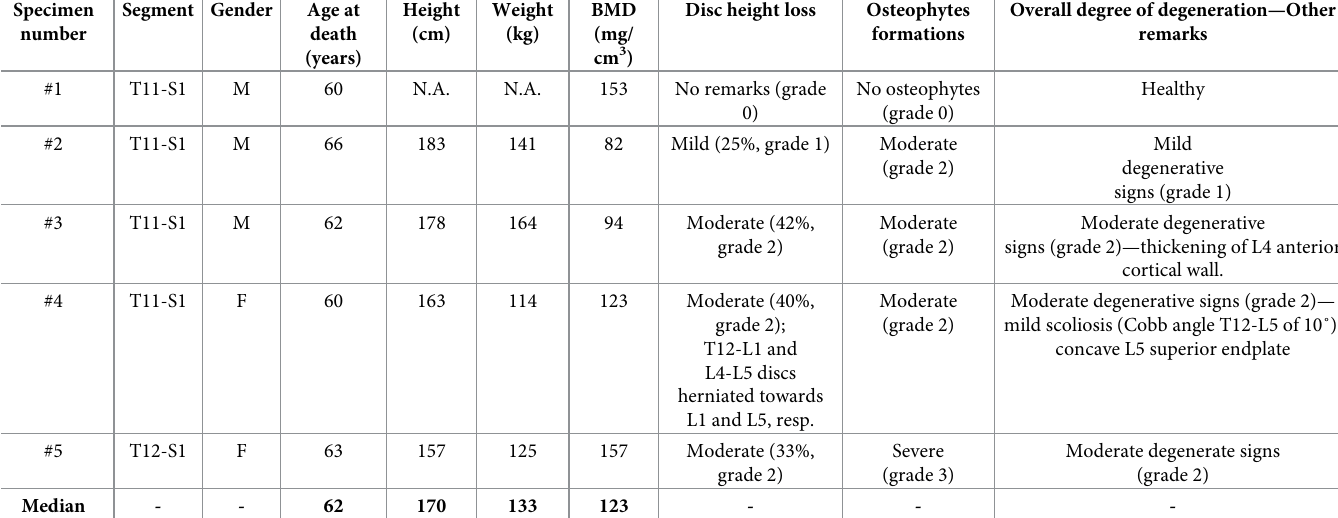
Table 1. Details of the specimens: the first columns report the donor’s information. The last three columns report the radiographic assessment for L4 and L5, evaluated through CT scans according to [27] (the CT scans for each individual specimen is reported in the S1 Fig). The IVD height loss and osteophytes formations were assessed according to [27]. Independently of the specimen extension T11-S1 or T12-S1, in all specimens the region of interest was the L3-L5 segment. Specimen Segment number